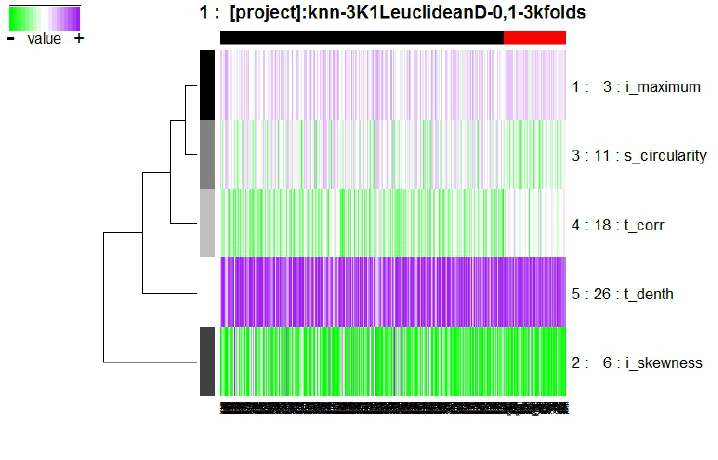
Figure 7. Model obtained from Galgo algorithm with K-Nearest Neighbors (K-NN)